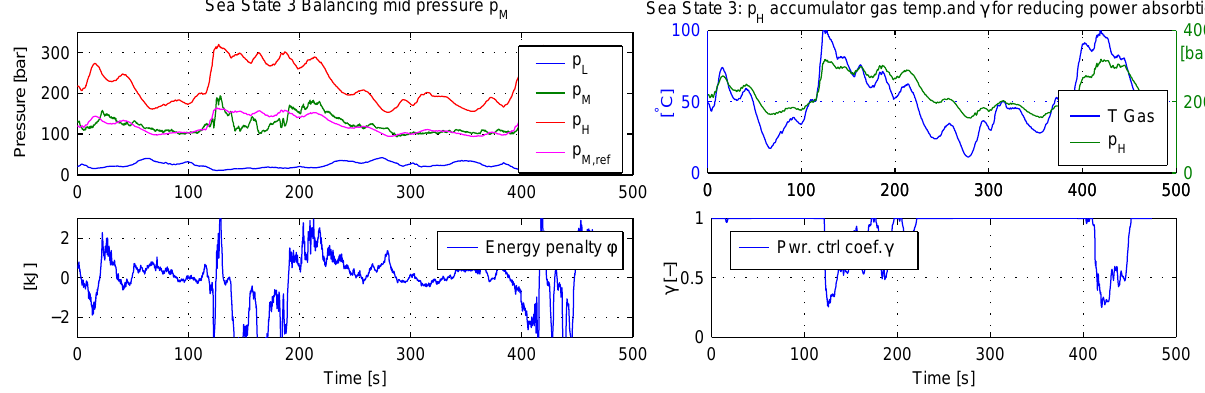
Figure 30. Controller performance and gas temperature of